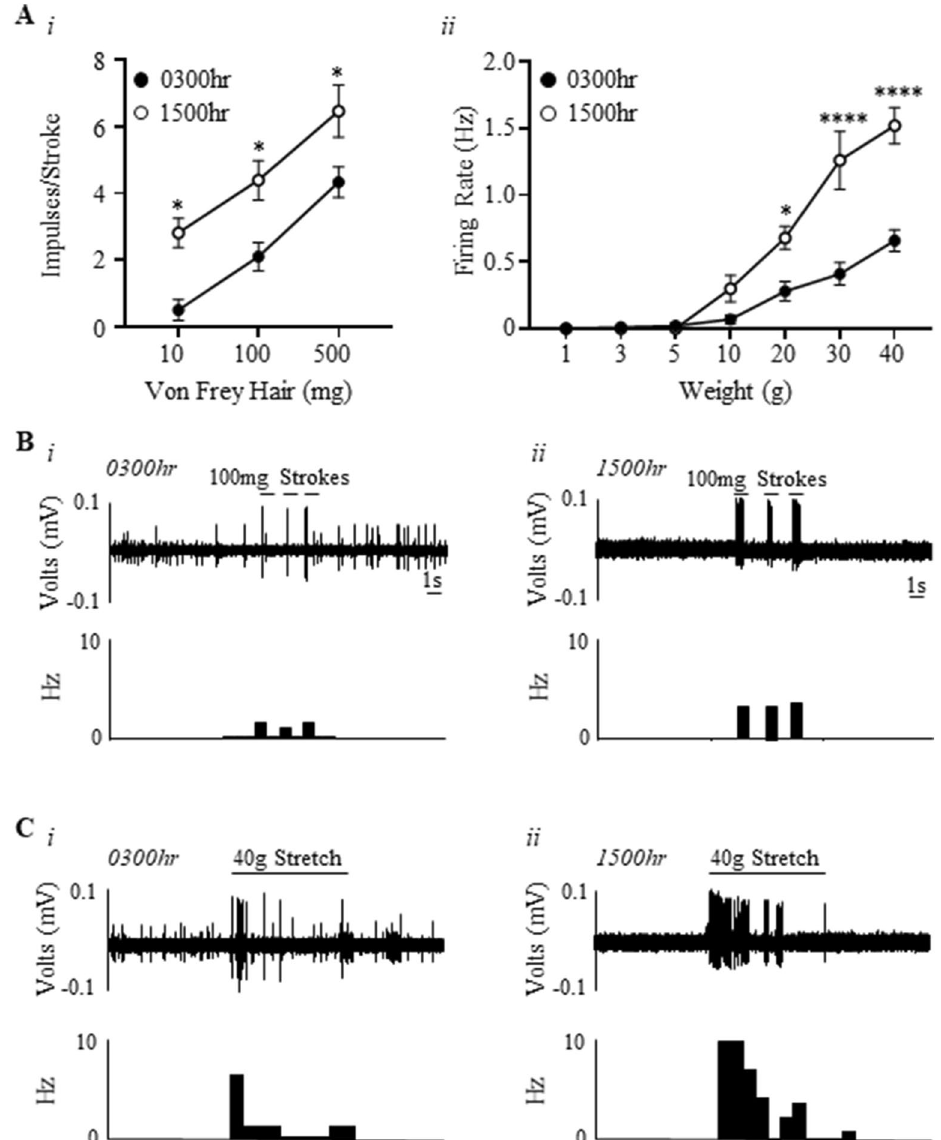
Figure 3. Bladder high-threshold muscular-mucosal afferents are more mechano-sensitive during the day compared to the night. ( A ) The response of high-threshold muscular-mucosal afferents to ( i ) mucosal stroking (10, 100, and 500 mg) and ( ii ) stretch (1–40 g) at 0300 h and 1500 h. N = 6, n = 12 at each time point. *P < 0.05, ****P < 0.0001. ( B ) An example of a raw trace of high-threshold muscular-mucosal afferent responses to 100 mg stroking at 0300 h and 1500 h. ( C ) An example of a raw trace of high-threshold muscular-mucosal afferent responses to 40 g stretch at 0300 h and 1500